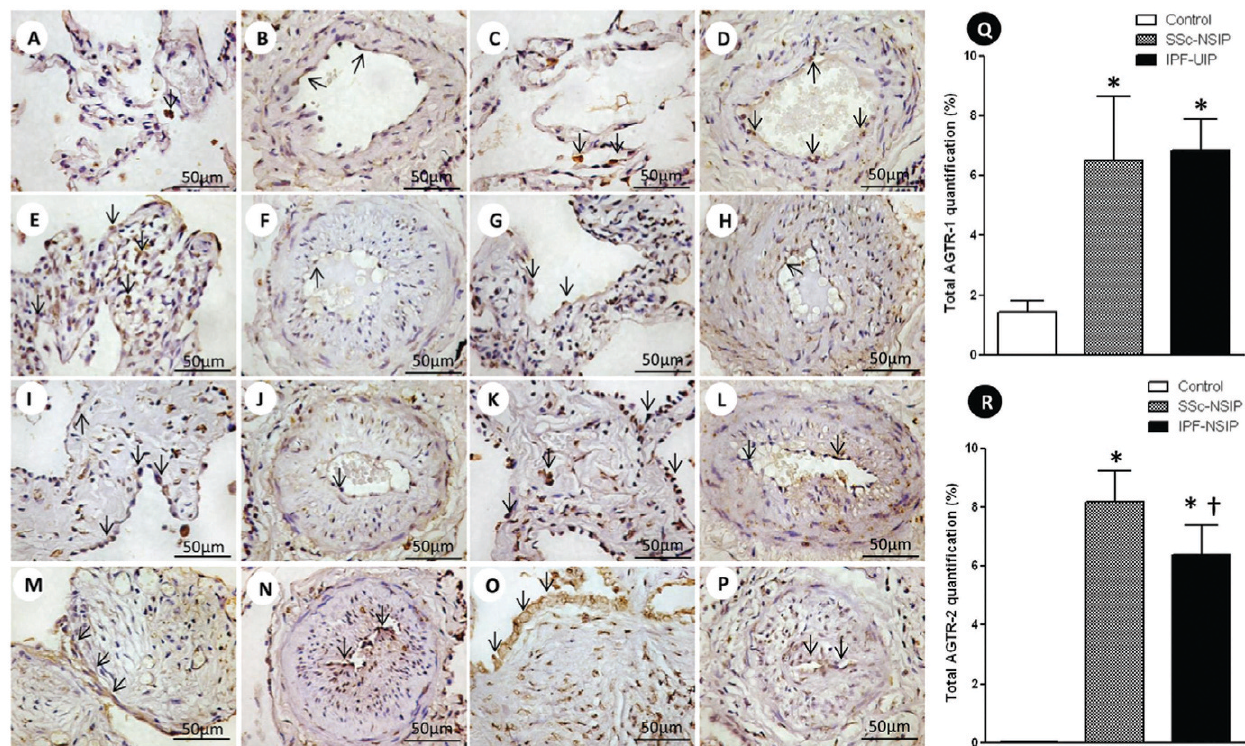
Figure 1 - Cellular expression of the angiotensin II type 1 receptor (AGTR-1) and AGTR-2 divided in septal areas and intrapulmonary vessels from normal control lungs, systemic sclerosis (SSc) and idiopathic pulmonary fibrosis (IPF). In (A) and (B), we observe a diffuse and minimal AGTR-1 (arrows) expression in the alveolar septal areas and in the intrapulmonary vessels of the controls. The AGTR-1 expression shows greater increases in the thickened alveolar septal region from the cellular SSc-NSIP (arrows, E) than in the fibrotic SSc- NSIP (arrows, I). In the intrapulmonary vessels, the expression of AGTR-1 (arrows) is minimal and similar in both groups (cellular SSc- NSIP, F and fibrotic SSc-NSIP, J). Increased expression of AGTR-1 (arrows) is observed in the septal areas (M) and intrapulmonary vessels (N) of IPF-UIP. In (C) and (D), we observed AGRT-2 (arrows) expression in the septal areas and intrapulmonary vessels from the controls. In (G) and (K), we observed a similar expression of AGTR-2 (arrows) in the septal areas of cellular and fibrotic SSc-NSIP. Increased expression of AGTR-2 (arrows) is observed in the intrapulmonary vessels of fibrotic SSc-NSIP (L) compared to cellular SSc-NSIP (H). The expression of AGTR-2 (arrows) is more evident in the septal areas of IPF-UIP (O) than in the intrapulmonary vessels (P) of this histologic pattern. Q and R show the total values of AGTR-1 and AGTR-2 and the results analyzed by a one-way ANOVA with the Bonferroni multiple comparisons test for the control, SSc-NSIP and IPF-UIP groups. (*) Significantly higher AGTR-1 expression was observed in the SSc-NSIP and IPF-UIP lungs compared with the control group ( p= 0.001 and p= 0.001, respectively). A similar situation was observed with AGTR-2 expression from the SSc-NSIP and IPF-UIP patterns compared to the control group ( p , 0.001 and p , 0.001, respectively). ( { ) Significantly higher expression of AGTR-2 in the SSc-NSIP group was observed when compared with the IPF-UIP group ( p =0.04) by Student’s t-test.